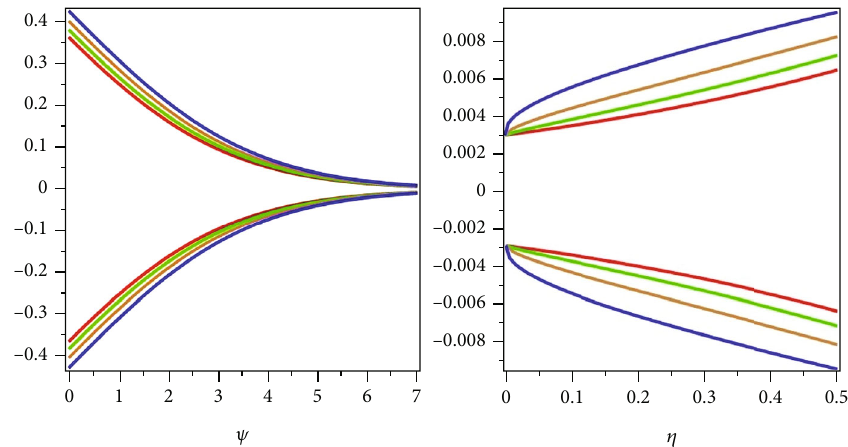
Figure 8: The fi rst graph shows the fuzzy 3D upper and lower fi gure of the various fractional orders of γ .